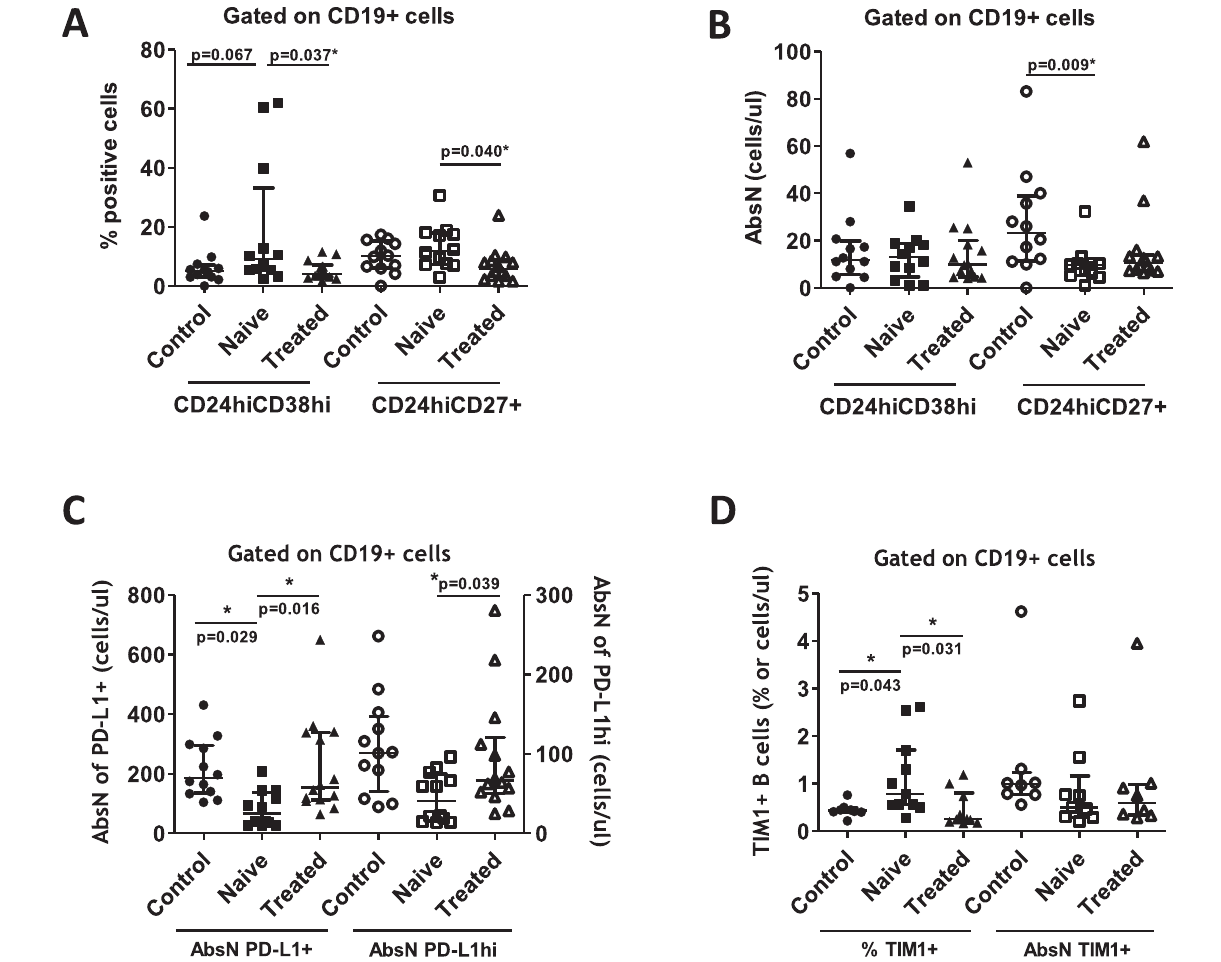
Fig 2. Breg compartments in HIV+ and healthy individuals. (A) Frequencies and (B) absolute numbers (AbsN) of CD24 hi CD38 hi and CD24 hi CD27 + Breg subsets. (C) Absolute numbers of PD-L1 + and PD-L1 hi B cells. (D) Frequencies and absolute numbers of TIM-1 + B cells. All of these subsets were determined in whole blood using cell surface labeling. Frequencies of Breg were obtained relative to CD19 + cells. Medians ± IQRs are represented. Control: Healthy individuals. Na ï ve: HIV+ treatment-na ï ve individuals. Treated: Treated-HIV + individuals. � = p < 0.05 when comparing conditions. Each symbol corresponds to an